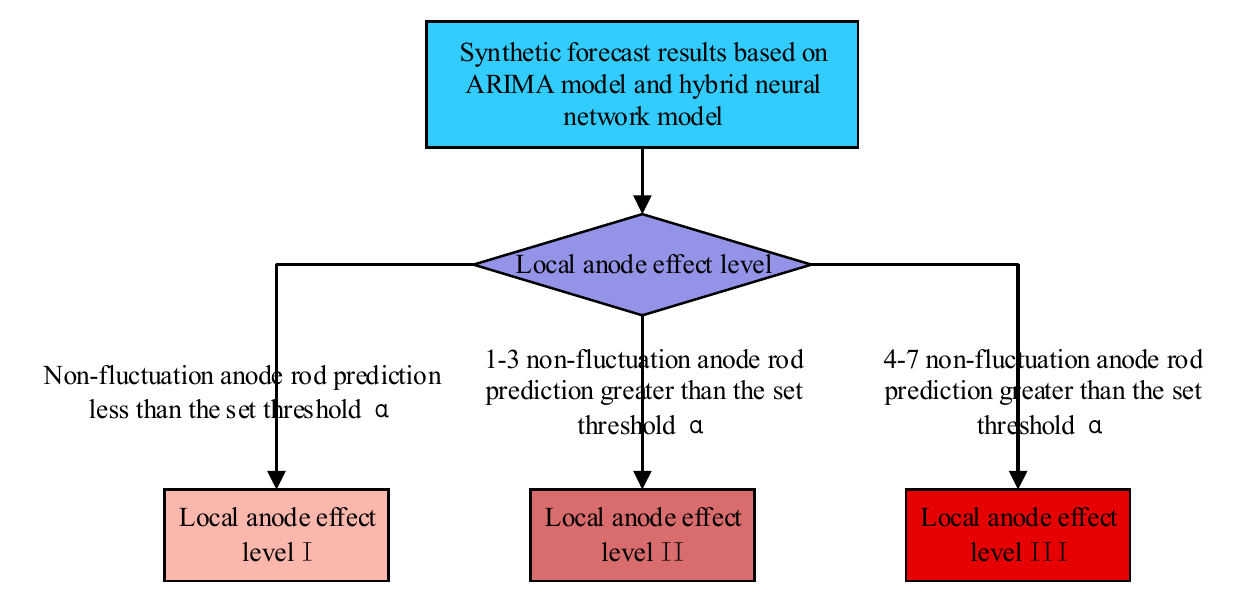
Figure 7. Levels of local anode effect.